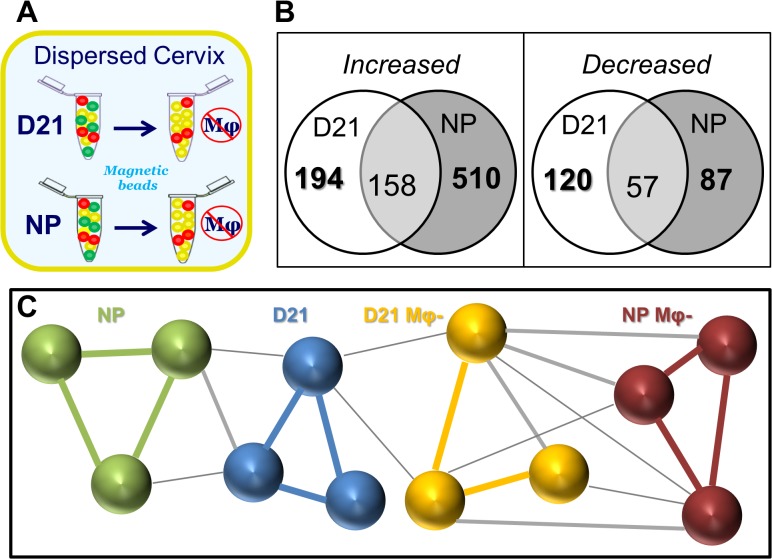
Subtractive approach in which macrophages were depleted from dispersed cervix from prepartum and nonpregnant mice to identify differential gene expression by macrophages.
A. Cervix from perfused adult female Sprague-Dawley rats, on prepartum day 21 post-breeding (D21) or non-pregnant (NP) was carefully trimmed and dispersed (n = 6 each). Mφs were removed by magnetic bead separation from 3 rats in each group as described in detail in Methods. B. Venn diagram of differentially expressed Mφ genes in the cervix from prepartum (D21) or nonpregnant (NP) rats. Genes were exclusively increased or decreased in cervices from D21 or NP rats, except in the overlap region which indicates genes that were increased or decreased in cervices from both D21 and NP rats. No gene whose expression increased or decreased in the cervix from D21 or NP groups then decreased or increased in the cervix from NP or D21 groups, respectively. Number is the average of differentially expressed Mφ genes in whole divided by Mφ -depleted cervix/group (p<0.01, fold >2 or <-2; n = 3 rats). C. Pearson correlation of clustering patterns of gene expression in cervix of individual rats in NP and D21 groups with or without macrophages (Mφ-). Lines connecting microarray analysis for each individual indicates R>0.9 (group specific colors), R = 0.851–0.89 (grey), or R = 0.8–0.85 (thin grey).